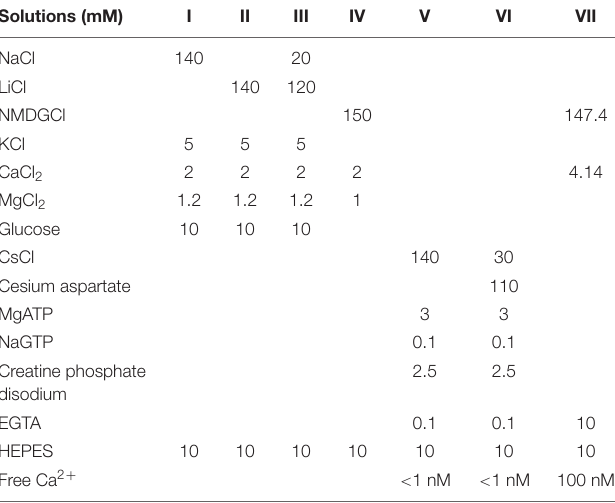
TABLE 2 | The composition of pipette solutions and bath